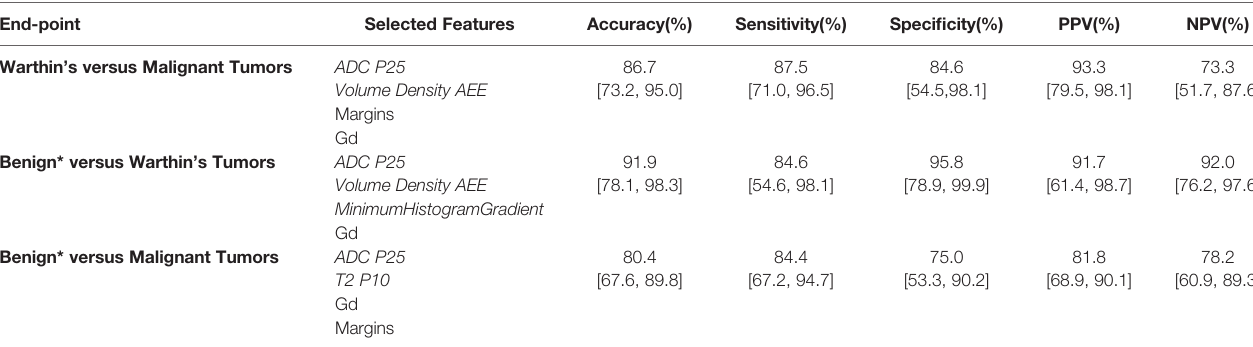
TABLE 3 | Predictive Performance of the three models on the training